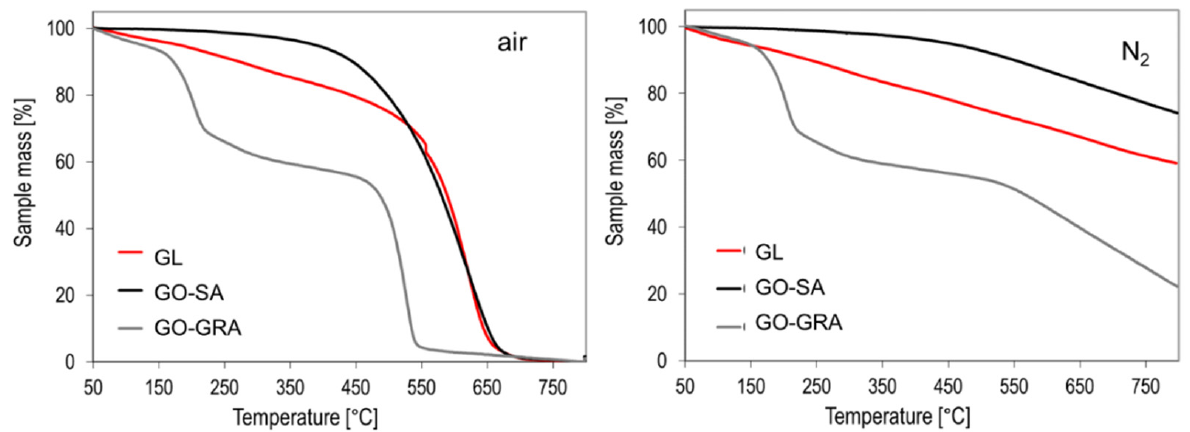
Figure 2. TGA profiles of GL, GO-SA, and GO-GRA in oxidizing (air, left panel) and inert (N 2 , right panel) environments.